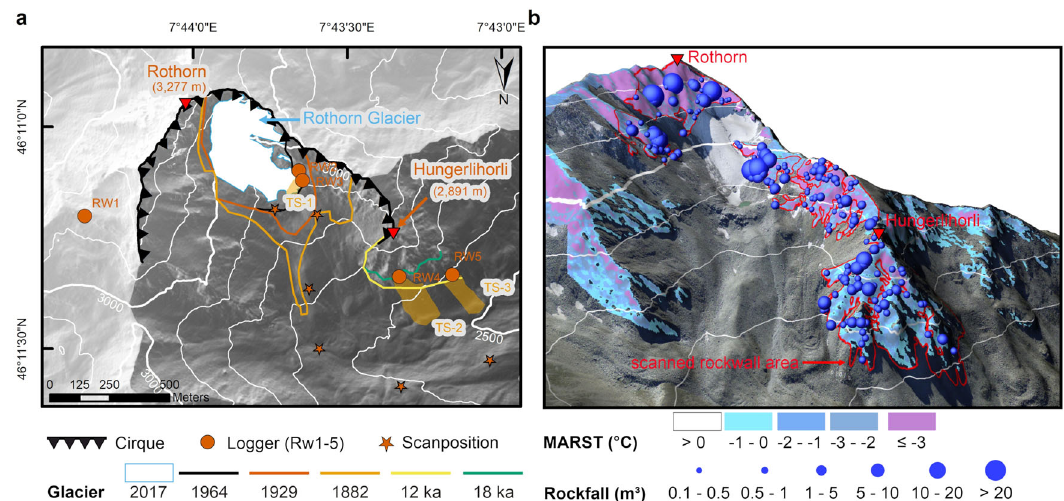
Fig. 2 Rockfall events along with glacier history, permafrost distribution and talus slopes in the Hungerli Valley. a Scanned rockwalls of the Hungerli Valley with highlighted glacier history (coloured lines). Instrumented rockwalls (red point), investigated talus slopes (brown polygons) and scan positions (red stars) are highlighted (source: swissALTI3d from swissTopo). b 3D representation of scanned rockwall area (red rectangle), modelled permafrost distribution and quanti fi ed rockfall volumes for 2016 to 2019 (source: swissALTI3d and swissIMAGE25 from swissTopo).